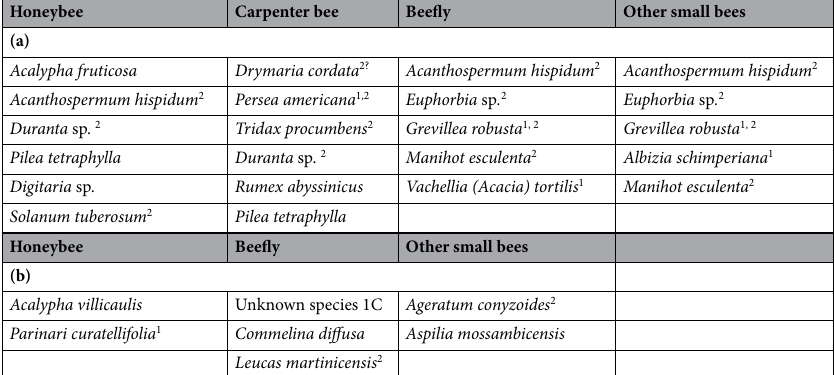
Table 1. The top 5% of non-ubiquitous, non-scarce plant species most regularly associated with each major potential pollinator guild for common bean in (a) Tanzania and (b) Malawi. 1 Tree species. 2 Not native to Eastern or Southern Africa. Note that carpenter bees were not recorded from pan traps during the survey period in Malawi, and where the top species was not identifiable from vouchers available, the next most commonly associated plant species is also included.